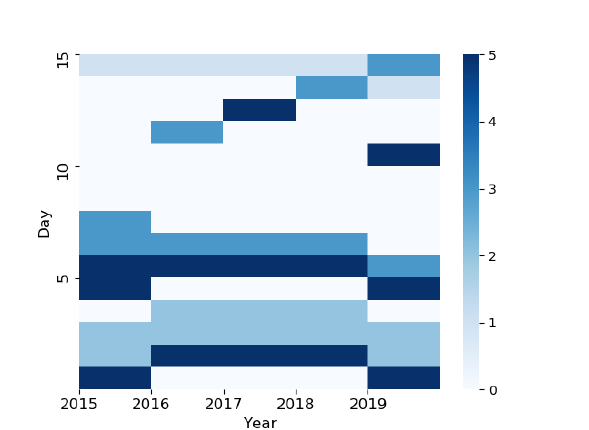
Figure 21: Clustering output for O 3 for last 15 days in Q 4 over 2015 to